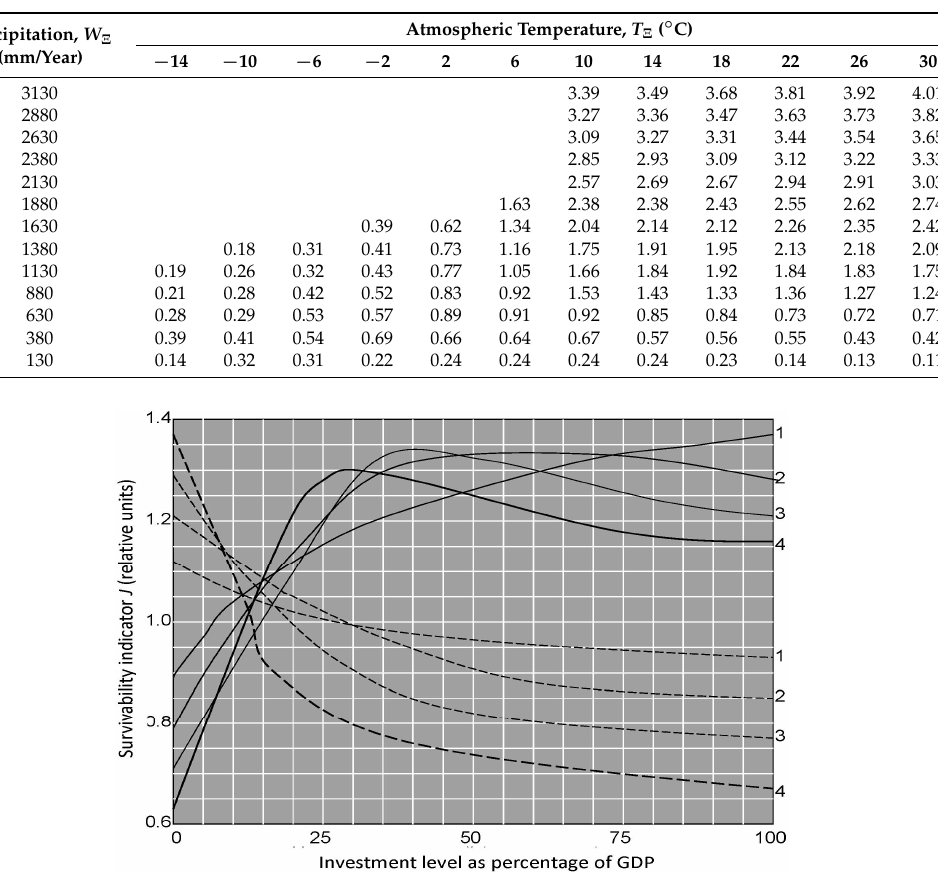
Figure 10. The global and regional population dynamics.